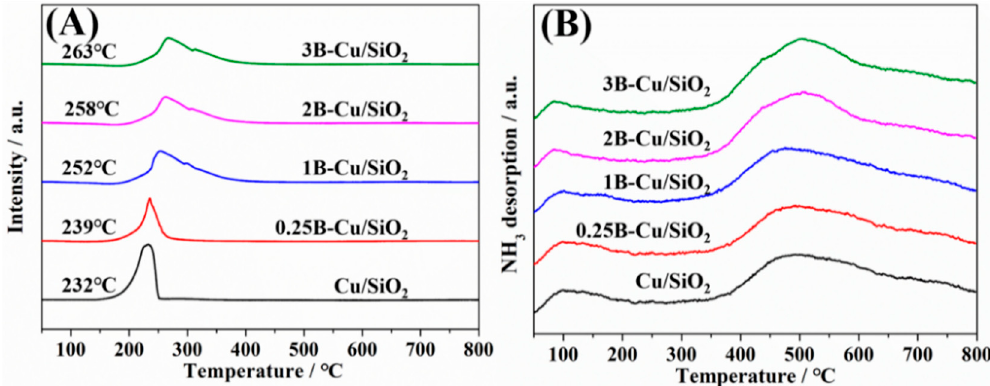
Figure 3. H 2 -TPR ( A ) and NH 3 -TPD ( B ) profiles of x B-Cu/SiO 2 catalysts.